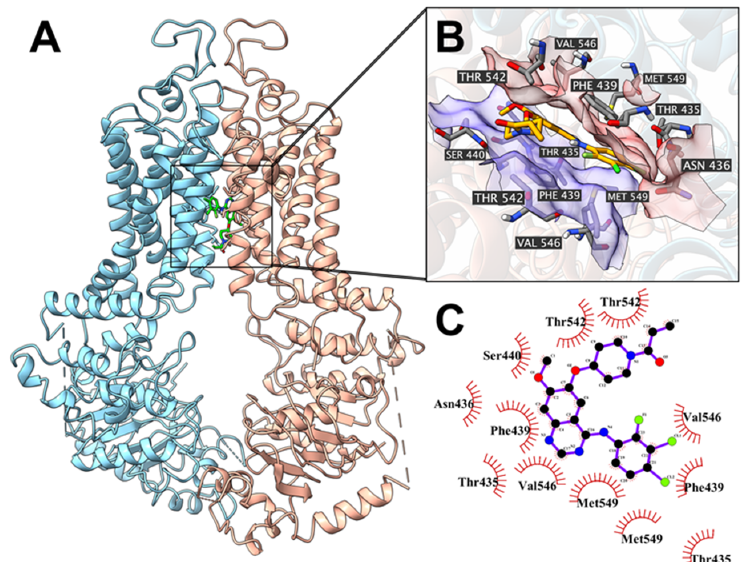
Figure 9. The interactions between poziotinib and the human ABCG2 transporter protein model. ( A ) An overview of the best-scoring pose for poziotinib in the drug-substrate site of the ABCG2 protein model (PDB: 6VXI). ABCG2 is displayed as colored tubes and ribbons (chain A: red; chain B: cyan). Poziotinib is displayed as colored sticks. ( B ) Details of interactions between poziotinib and ABCG2 protein drug-substrate binding site. ABCG2 helices are displayed as colored ribbons. Important residues are displayed as colored sticks (carbon: grey; oxygen: red; nitrogen: blue; hydrogen: white). The surface formed by important residues are depicted as solid planes (chain A: red; chain B: purple). Poziotinib is displayed as colored sticks (carbon: orange; oxygen: red; nitrogen: blue; chloride: lime; fluoride: light green). ( C ) A 2D diagram of the interaction between poziotinib and the ABCG2 transporter. The important amino acids are displayed as red arcs or dots/sticks.